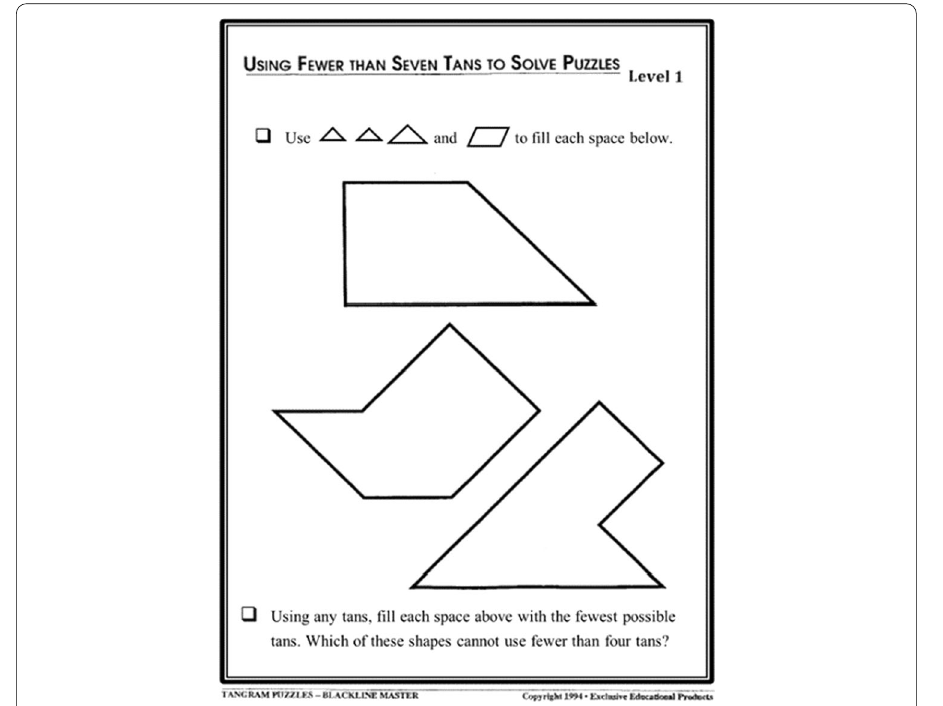
Fig. 4 Challenge Level 1 Sheet for Stage 2 taken from Tangram Blackline Masters